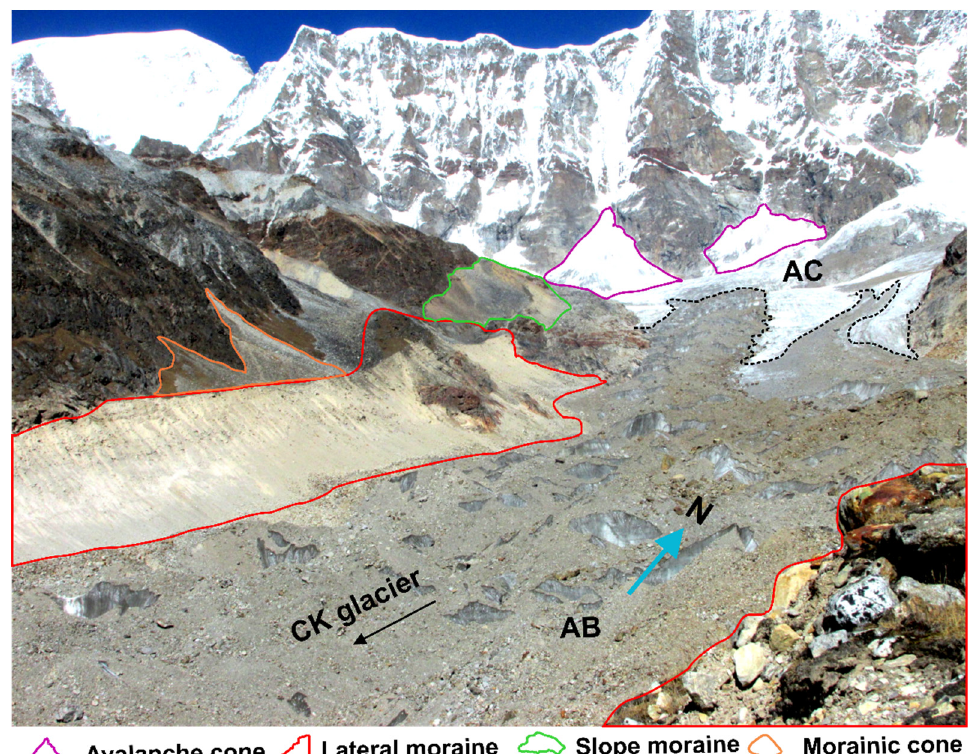
Figure 10. Field photograph of the upper reaches of the debris-covered glacier CK lateral moraines (red polygons) enclosing the glacier; the black dashed separation line marking the accumulation area (AC), in the upper part and debris-covered ablation area (AB), in the lower part; the avalanche cones (magenta colored polygons).